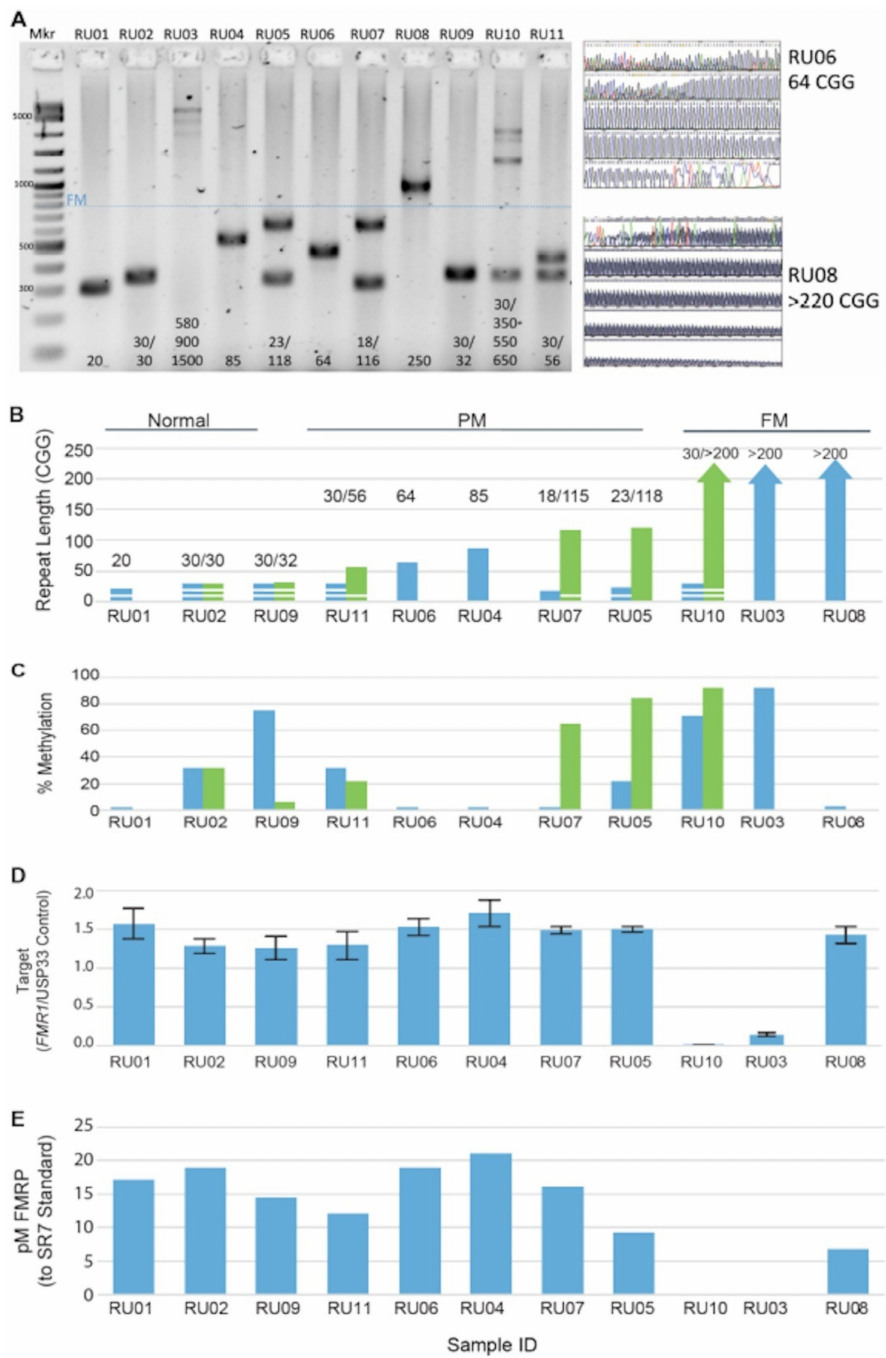
Figure 1. ( A ) GS-PCR / AGE and Sanger sequencing for repeat sizing. ( B ) RP-PCR / CE repeat sizing and AGG interruptions (represented as horizontal column breaks, determined using Xpansion Interpreter PCR). ( C ) Methylation percentage assessed with mPCR. ( D ) FMR1 mRNA expression levels for matched cell lines (RT-qPCR), and ( E ) FMRP levels normalized to the recombinant FMRP peptide GST-SR7. In ( B , C ), the second (usually longer) CGG allele for female cell lines is shown in green; all others are given in